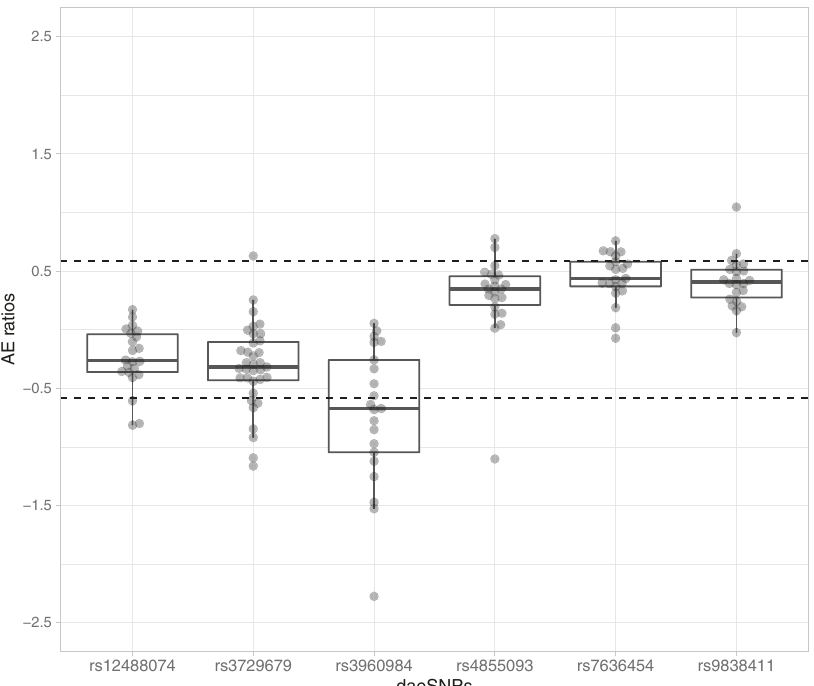
Fig. 1 Cis-regulatory variation impacts on PIK3CA gene expression in normal breast tissue. AE ratios for six daeSNPs in the PIK3CA gene region, each dot is a heterozygous individual for the corresponding variant indicated in the x-axis, dotted lines delimit the levels of 1.5-fold difference for either allele preferential expression ( AE j j ¼ 0 : 58 ). Boxplots display the median, the lower and upper hinges corresponding to the fi rst and third quartiles, and lower and upper whiskers corresponding to the smallest and largest values from the 1.5 * IQR (interquartile range),